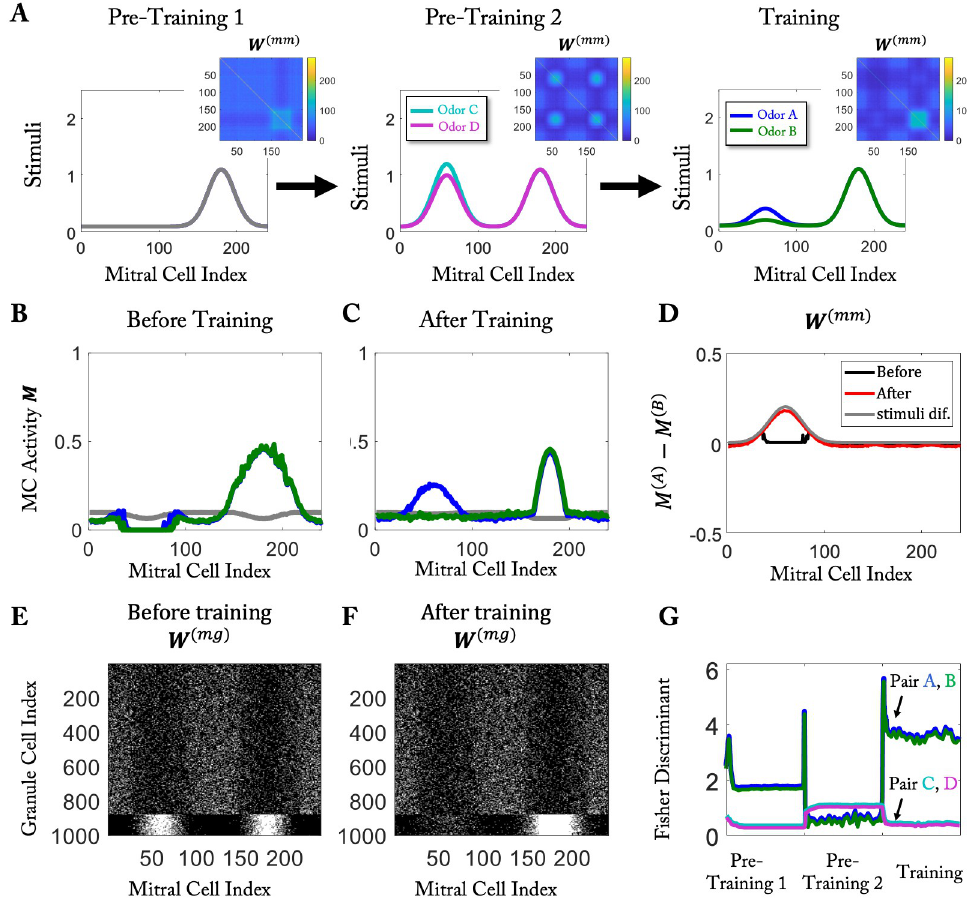
Fig 8. The discrimination of weak components of similar stimuli is abolished by training with strong components, but recovers through training with weak components. (A) Protocol: left: pre-training 1 with only 1 odor; middle: pre- training 2 based on a mixture of that and a dissimilar odor; right: training with a mixture in which the second component is only weak. (B) Response to the training stimulus before training; due to pre-training 2 the response to the weaker odor component is suppressed completely. (C) Training with the weaker component recovers that component. (D) MC response difference between odors A and B before and after training. (E,F) MC-GC connectivity before and after training. (G) Fisher discriminant for odor pair (A,B) and